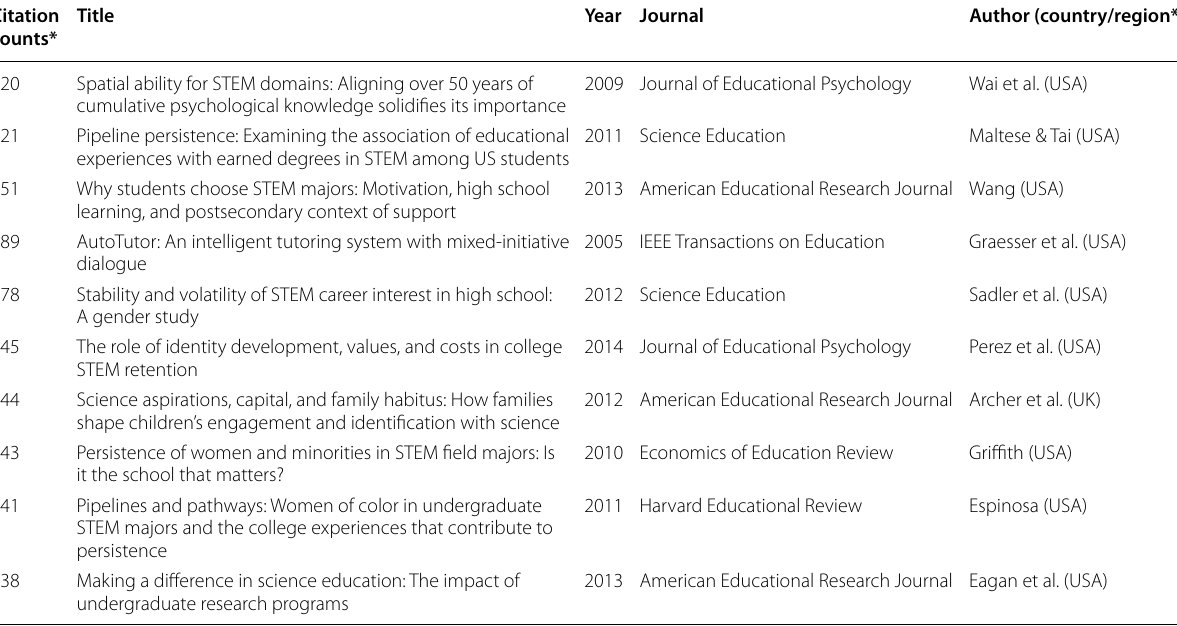
Table 3 Top ten most-cited empirical research articles published between 2000 and